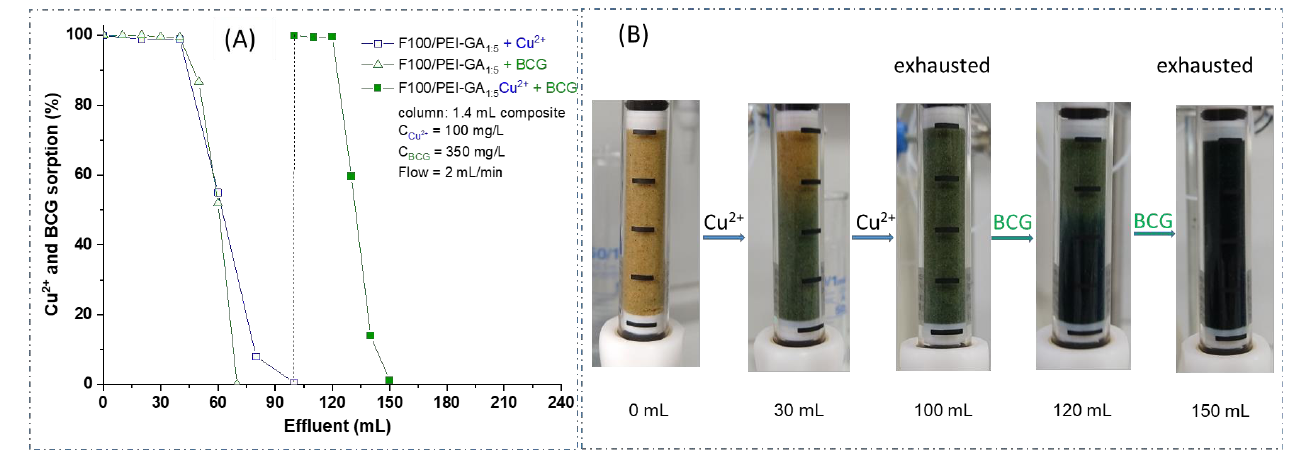
Figure 10. ( A ) Sorption efficiency of Cu 2+ and BCG onto F100/PEI-GA 1:5 from mono-component influent solution carried out in separated runs (empty symbols) and consecutive runs (full symbols), where BCG has been retained by the material exhausted in Cu 2+ ; ( B ) Column images after different effluent volumes passed through